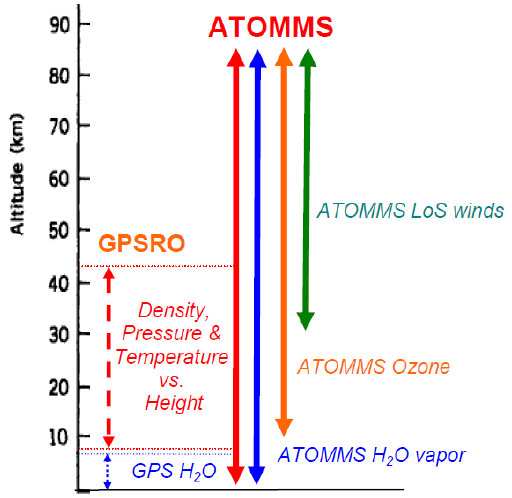
Fig. 2. Altitude comparison of ATOMMS vs. GPSRO. GPS profiles atmospheric density, pressure and temperature between the 230K altitude in the troposphere (where water vapor begins contributing significantly to refractivity) to approximately 45km, depending on electron densities in the ionosphere. At tropospheric temperatures warmer than 240K, GPS refractivity primarily constrains water va- por. In contrast, ATOMMS simultaneously profiles density, pres- sure, temperature and water vapor from the lower troposphere to the mesopause. ATOMMS profiles ozone from the upper troposphere to the mesopause. Above the ∼ 10mb level, ATOMMS will also de- termine line of sight (LoS) winds via the Doppler shift of the center of absorption